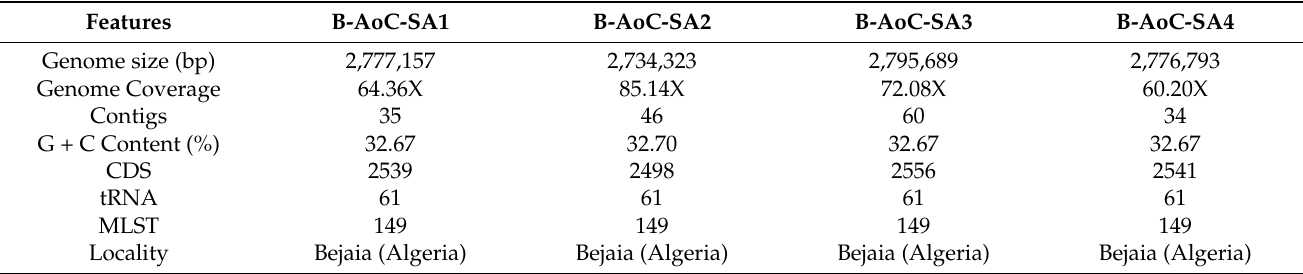
Table 1. General genome characteristics of MRSA strains isolated from bat